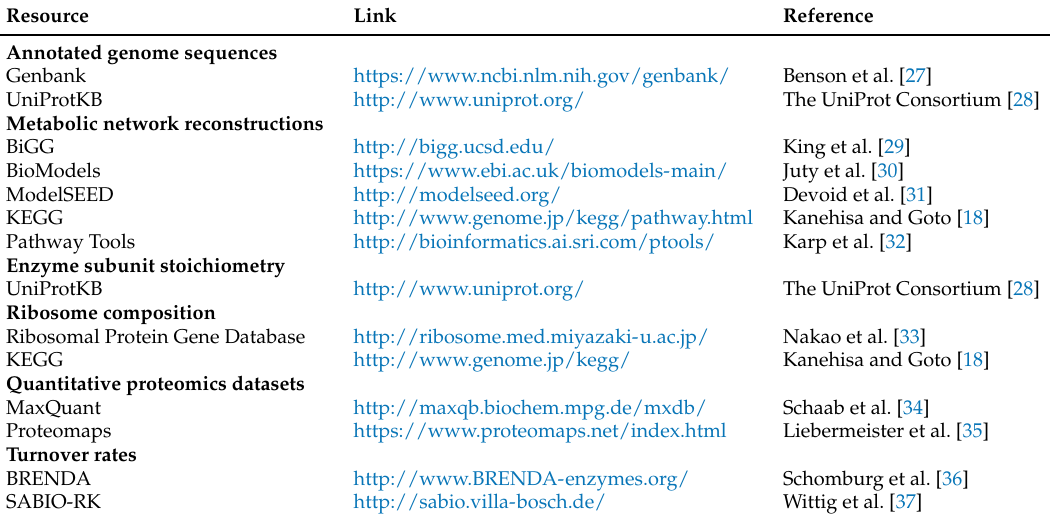
Table 1. Databases where the necessary information needed to build a metabolic resource allocation model can be